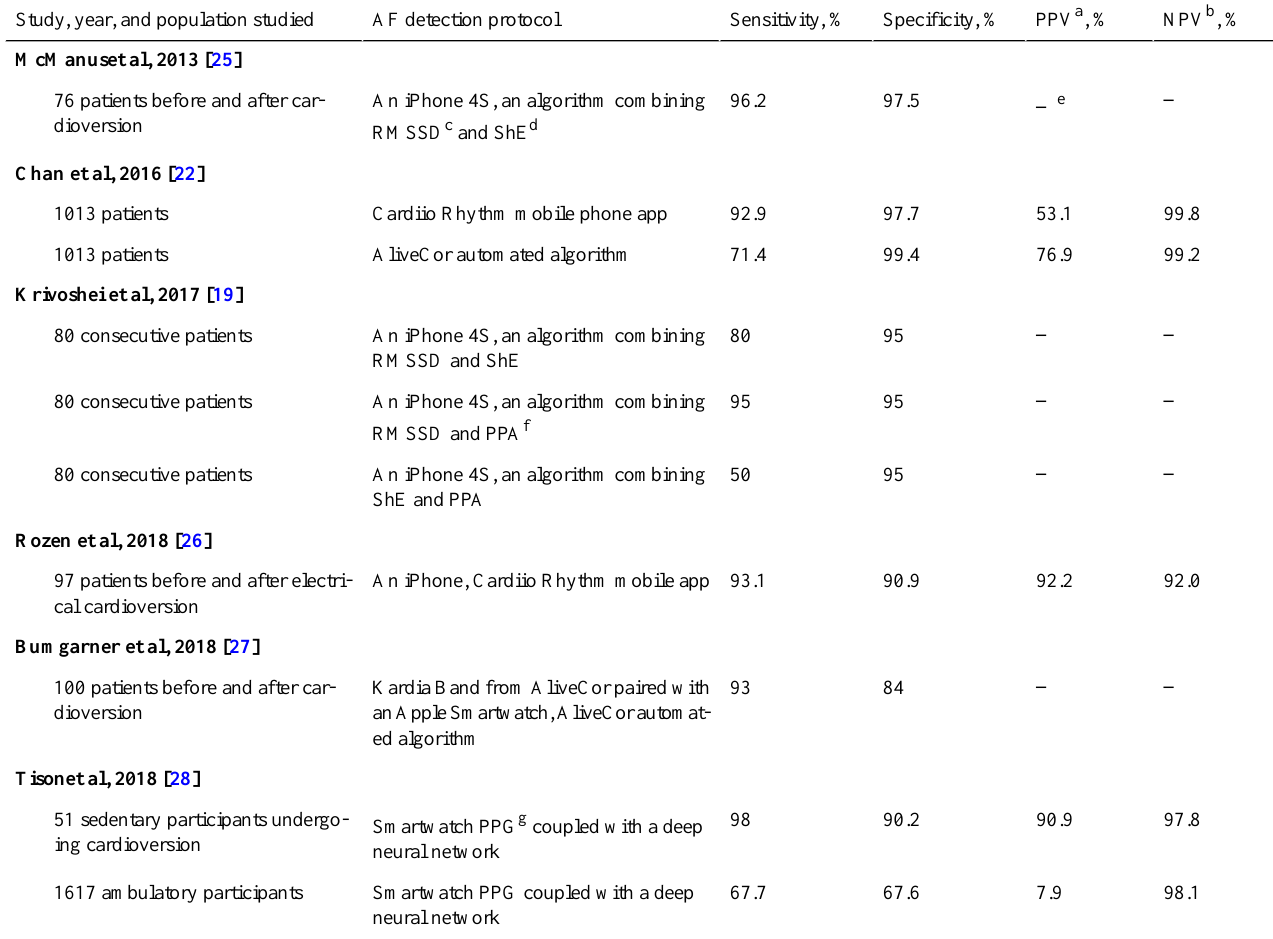
Table 3. Data from the literature on atrial fibrillation (AF) detection with different